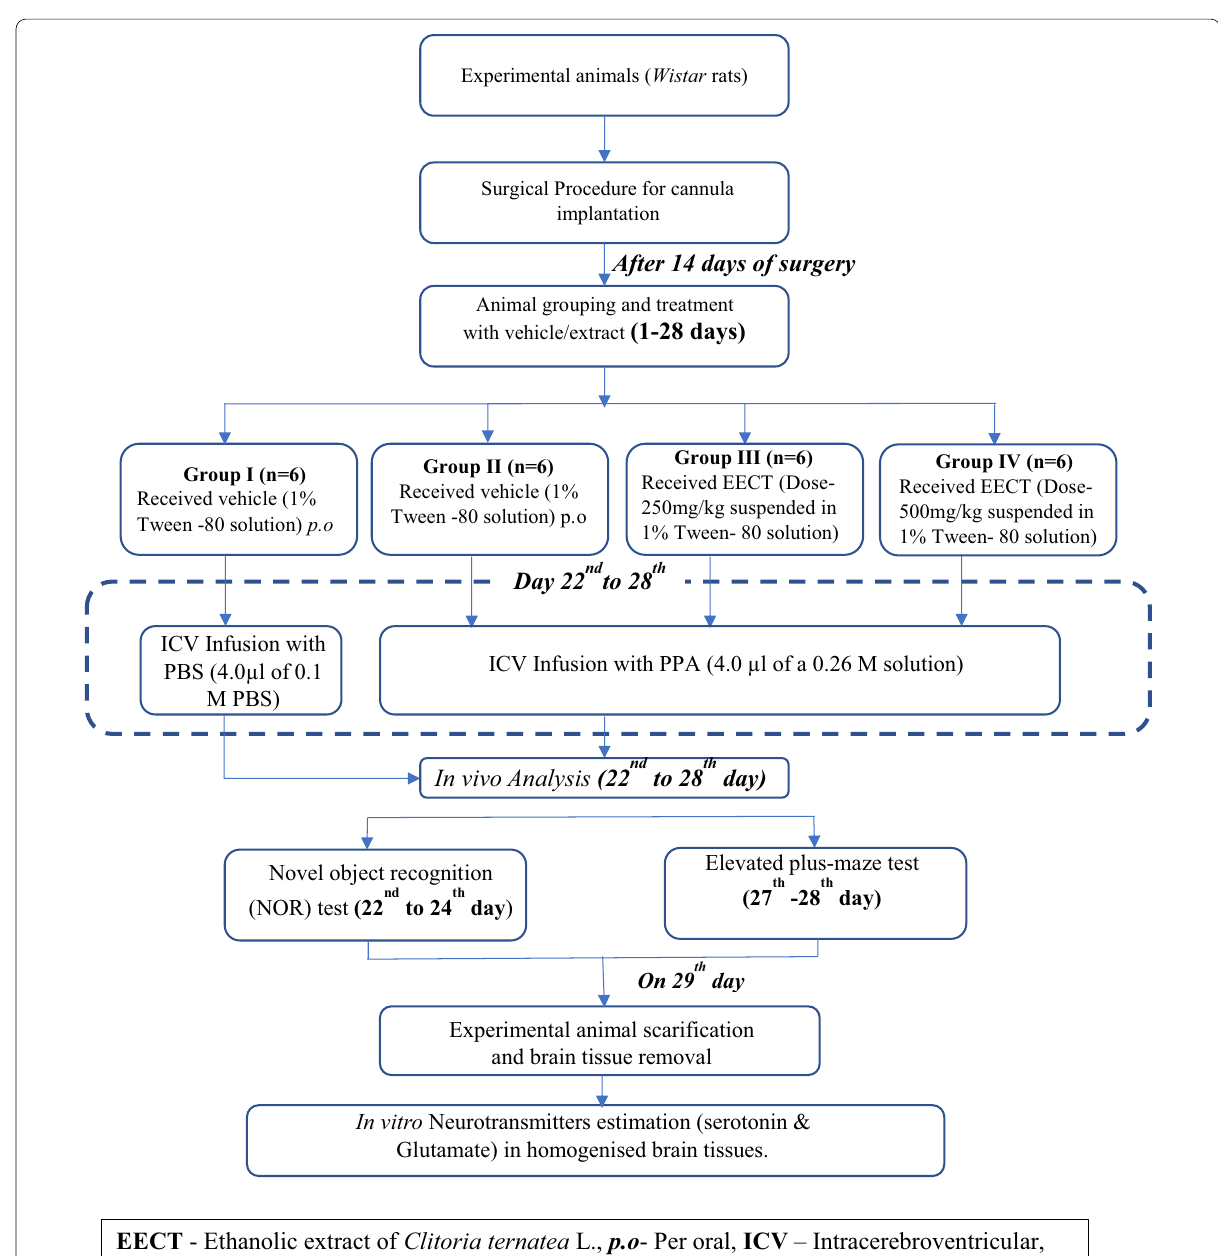
Fig. 1 Schematic diagram of the experimental